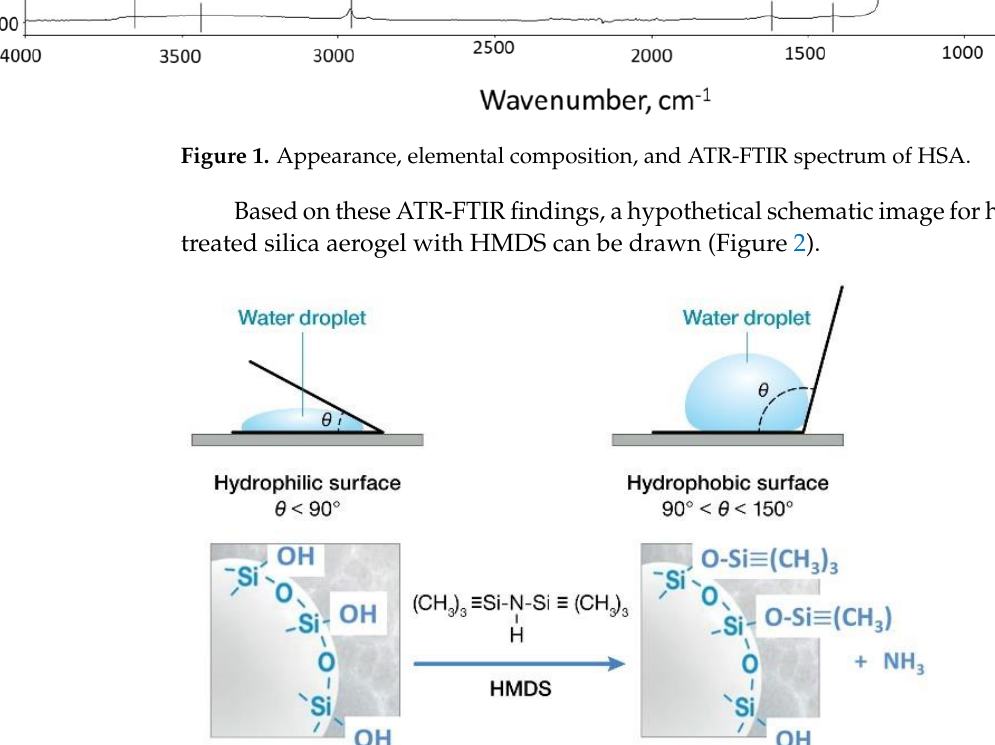
Figure 2. Hypothetical chemical structure and surface-wetting behaviors of non-treated and HDMS- treated HSA.